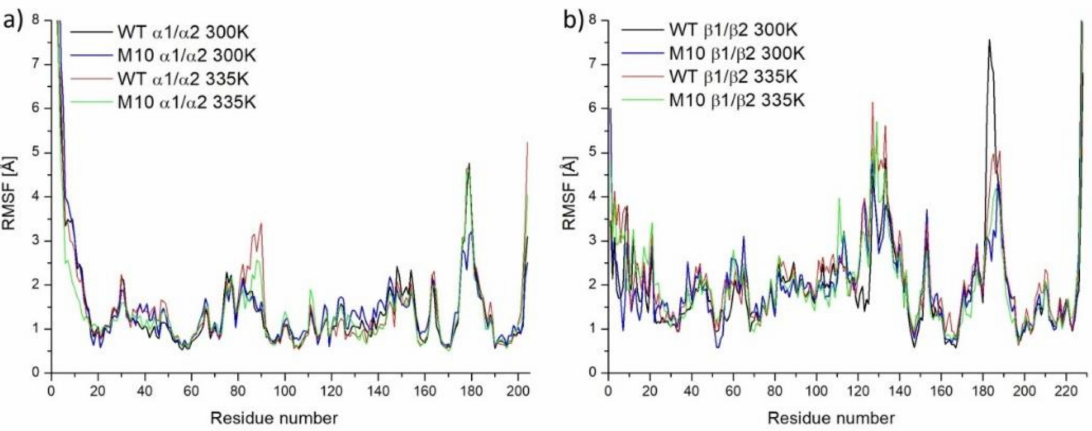
Figure 5. Averaged C α atoms fluctuations for subunit α in 300 K and 335 K ( a ) and for subunit β 300 K and 335 K ( b